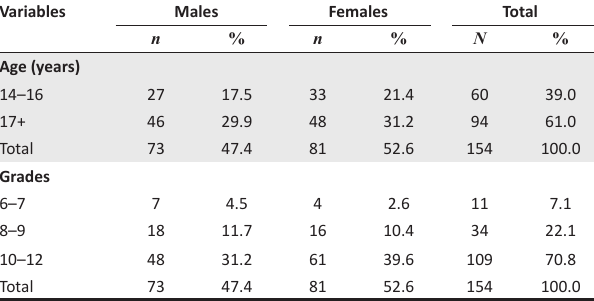
TABLE 1: Demographics of the participants. Variables